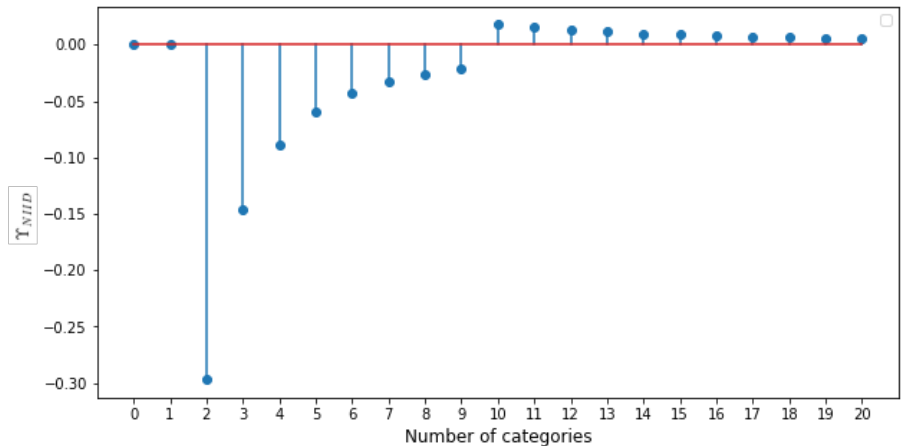
Figure 2. Dependence of irrelevance score component Υ NIID on Number of Categories ( N c ) for a problem with N o = 20 global classes.